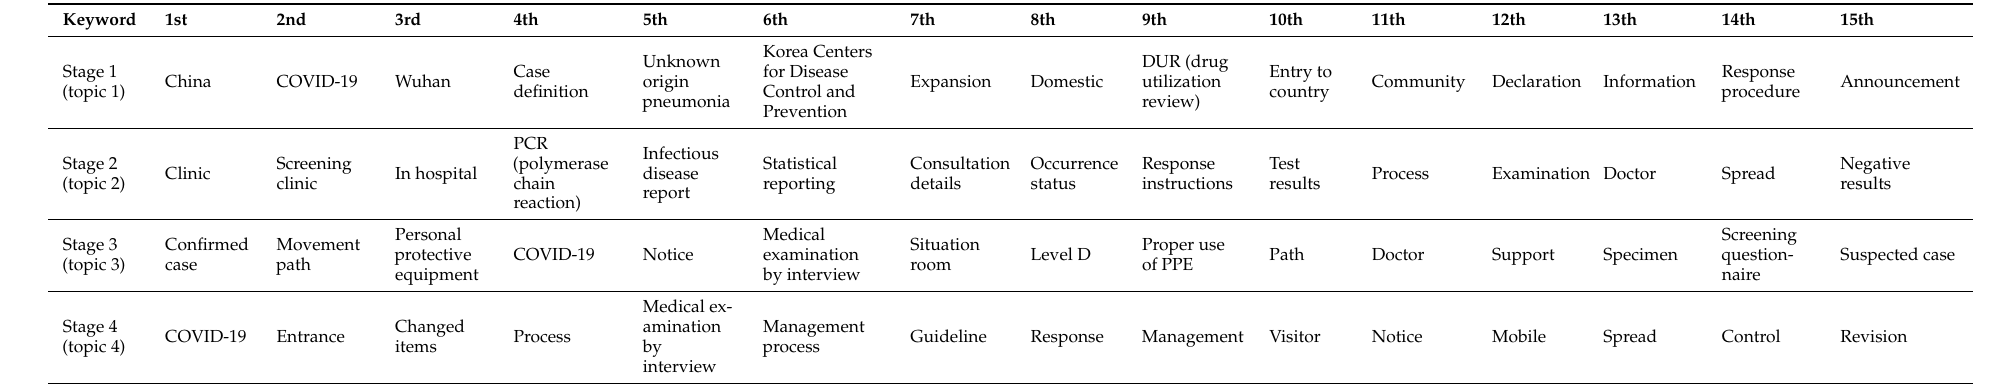
Table 2. Topic modeling of four